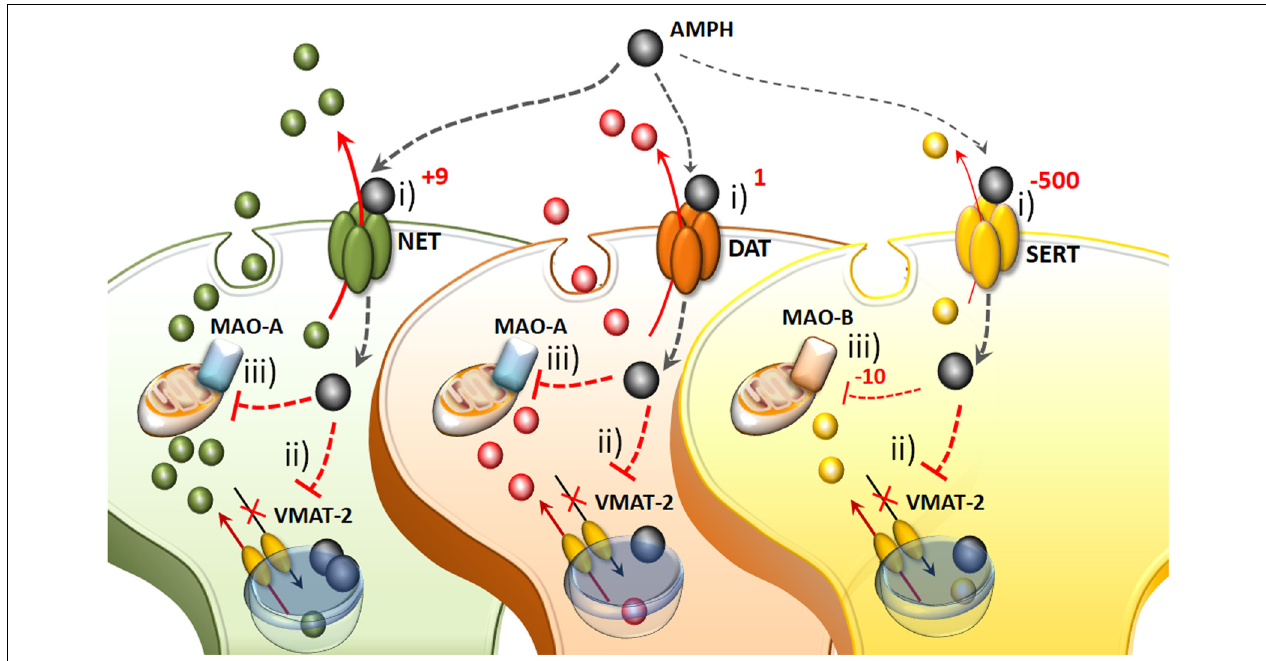
FIGURE 1 | The molecular mechanisms of amphetamine(s) (AMPHs) in monoamine-containing neurons. (i) The primary molecular target, which provides neuronal selectivity for AMPHs, consists in the plasma membrane transporter. In fact, AMPHs behave as competitive substrates for the re-uptake through the NE transporter (NET), dopamine (DA) transporter (DAT) and 5-HT transporter (SERT; Rothman and Baumann, 2003; Fleckenstein et al., 2007). These transporters normally work by taking up extracellular monoamines to the axoplasm, which is the main mechanism to terminate their activity (Iversen et al., 1965; Axelrod and Kopin, 1969; Coyle and Axelrod, 1971; Aggarwal and Mortensen, 2017). Cross-affinity between AMPHs and neurotransmitters contributes to generate the quite selective storage of AMPHs within specific neurons. Once bound to the plasma membrane transporter, AMPHs enter the axoplasm while reverting the transport direction (Sulzer et al., 1993). This occurs mostly for catecholamine neurons since AMPHs strongly discriminate between SERT, to which they bind with much lower affinity (500-fold less) compared with DAT and NET (Rothman and Baumann, 2003). In particular, AMPHs bind to the NET with five-to-nine-fold higher affinity compared with the DAT (Rothman and Baumann, 2003). This is the main reason why AMPHs release NE more potently than DA and much more than 5-HT (Rothman et al., 2001). (ii) Within monoamine axons, AMPHs encounter a second specific target called vesicular monoamine transporter type-2 (VMAT-2), which is also shared with monoamines. In this way, AMPHs enter the synaptic vesicles. At this level, AMPHs impair the acidification of the vesicle, which generates an acidic pH (Sulzer and Rayport, 1990; Sulzer et al., 1993, 1995). This acidic environment is erased by AMPHs, which rise the vesicular pH value from 4 up to 7, which corresponds to a 1,000-fold increase in the concentration of H + ions. Thus, monoamines, which are weak bases, are charged at low pH, while at a neutral pH lose their charge, and diffuse through the vesicle membrane, thus massively invading the axoplasm (Brown et al., 2000, 2002; Pothos et al., 2000). In this way, axonal monoamines either passively or via a reverted plasma membrane transporter fill extracellular space where they reach a massive concentration (Sulzer et al., 1995, 2005). (iii) The third molecular target, which is impaired by AMPHs, is the mitochondrial-bound enzyme monoamine oxidase (MAO). Both MAO-A/-B iso-enzymes oxidatively deaminate DA, NE and 5-HT. Nonetheless, MAO-A/-B isoforms differ in substrate preference, inhibitor affinity and regional distribution within either single neurons or different animal species (Robinson et al., 1977; Youdim, 1980; Sourkes, 1983; Gesi et al., 2001; Youdim et al., 2006; Bortolato et al., 2008). These differences are seminal to explain the specific effects of AMPHs within various monoamine neurons. In fact, MAO-A, are competitively inhibited by methamphetamine (METH) with a 10-fold higher affinity compared with MAO-B. MAO-A is placed within synaptic terminals of DA and NE neurons, while MAO-B are the only isoform operating within 5-HT terminals